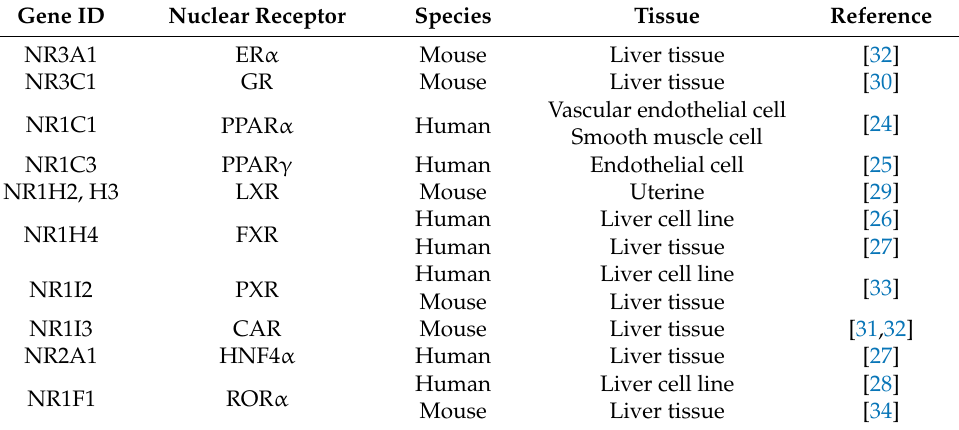
Table 3. The nuclear receptors associated with Sult1e1